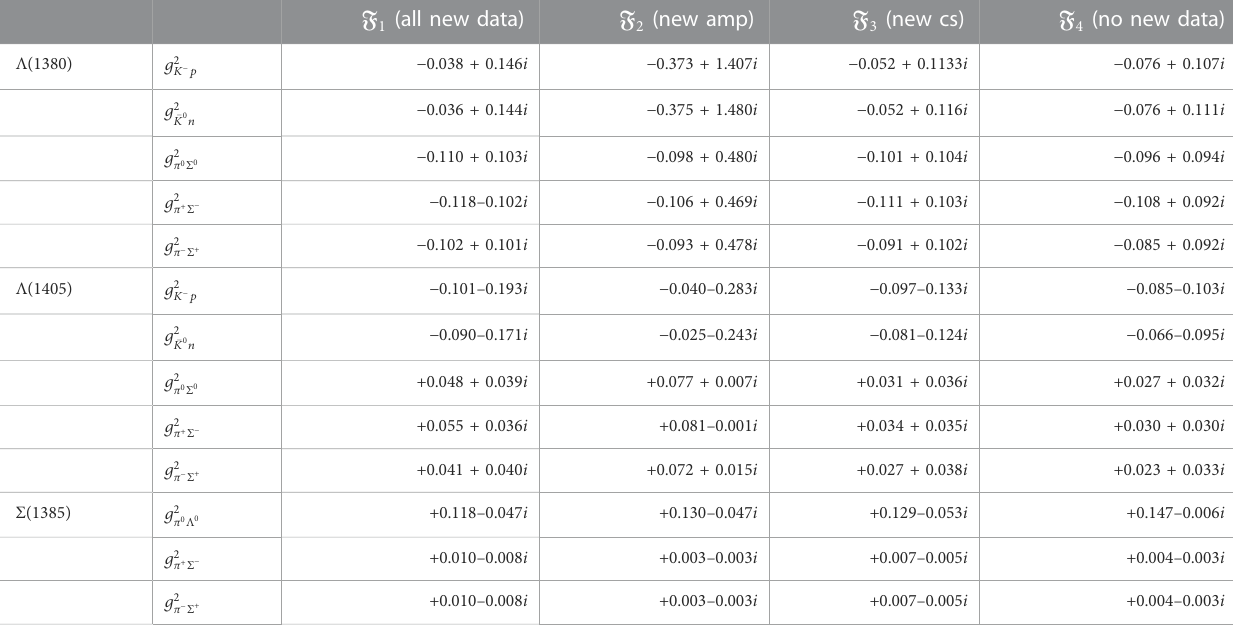
TABLEA2Individual andtotal χ 2 forthe fi tstrategy F 1 , ... , F 4 .Theindividual contributions tothe χ 2 arethe χ 2 observables (not minimized χ 2 contributions) are put in parentheses. Bottom part of the table collects the predicted pole positions W * ∈ C and the pole residues a g 2 . Uncertainties on the pole parameters in F 1 can be determined from the covariance matrix given in the auxiliary arXiv- fi les as described in Section